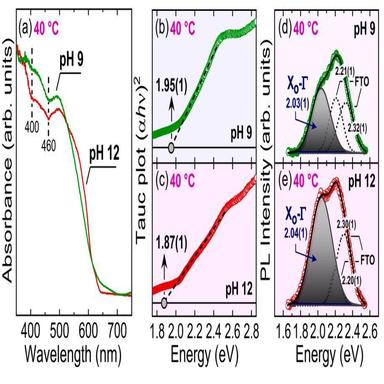
(a) Representative UV-Vis absorbance spectra for the Cu2O thin films electrodeposited at pH 9 and pH 12 and 40 ◦C. The measurements were performed at room temperature. (b) and (c) correspond to the Tauc plots of the absorbance spectra presented in (a). The dashed lines are linear fits of the absorption edges extrapolated to hν = 0 to find Eg. (d) and (e) present representative room temperature photoluminescence spectra for the Cu2O thin films electrodeposited at pH 9 and pH 12 and 40 ◦C. The spectra are nor